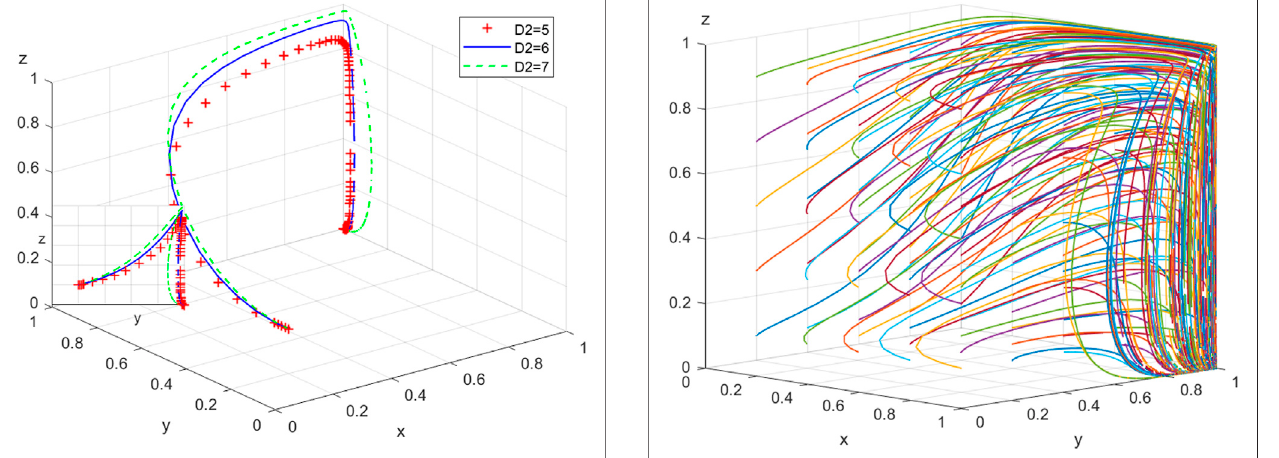
FIGURE 14 | Fifty evolution results of array 1.